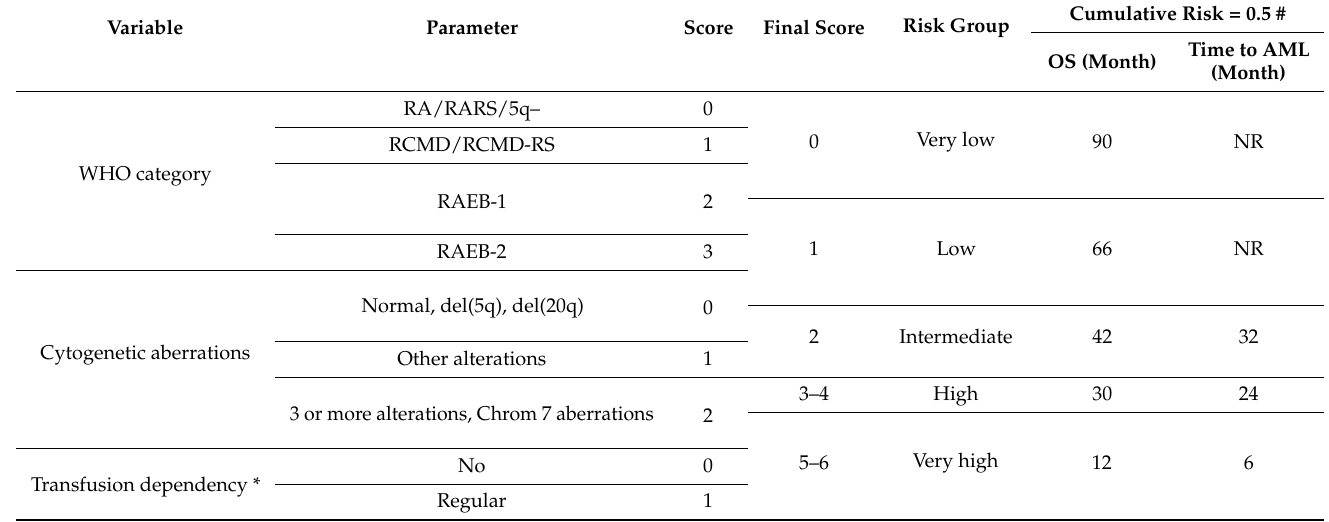
Table 2. World Health Organization classification-based Prognostic Scoring System (WPSS). Adapted from Malcovati et al., Journal of Clinical Oncology, 2007